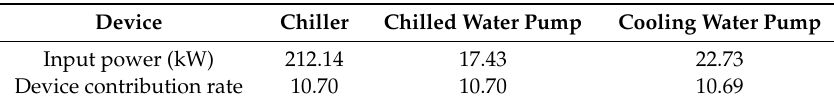
Table 8. Device input power after Matlab optimization.